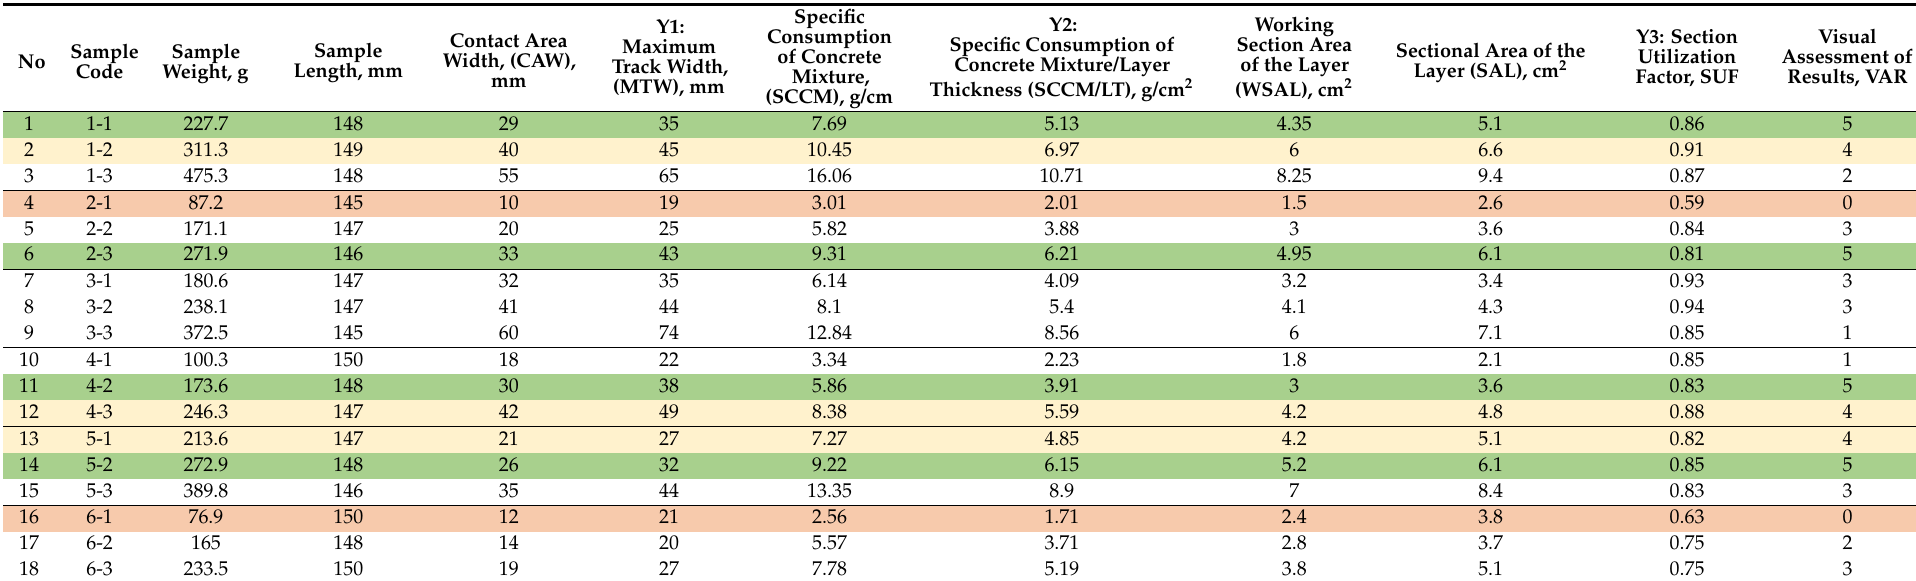
Table 2. Basic parameters of test